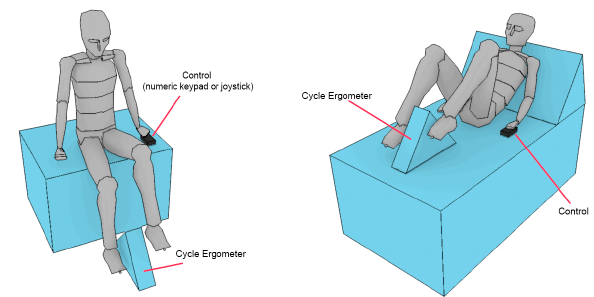
Figure 7. Ergonomic positions for the interaction with the exergame.